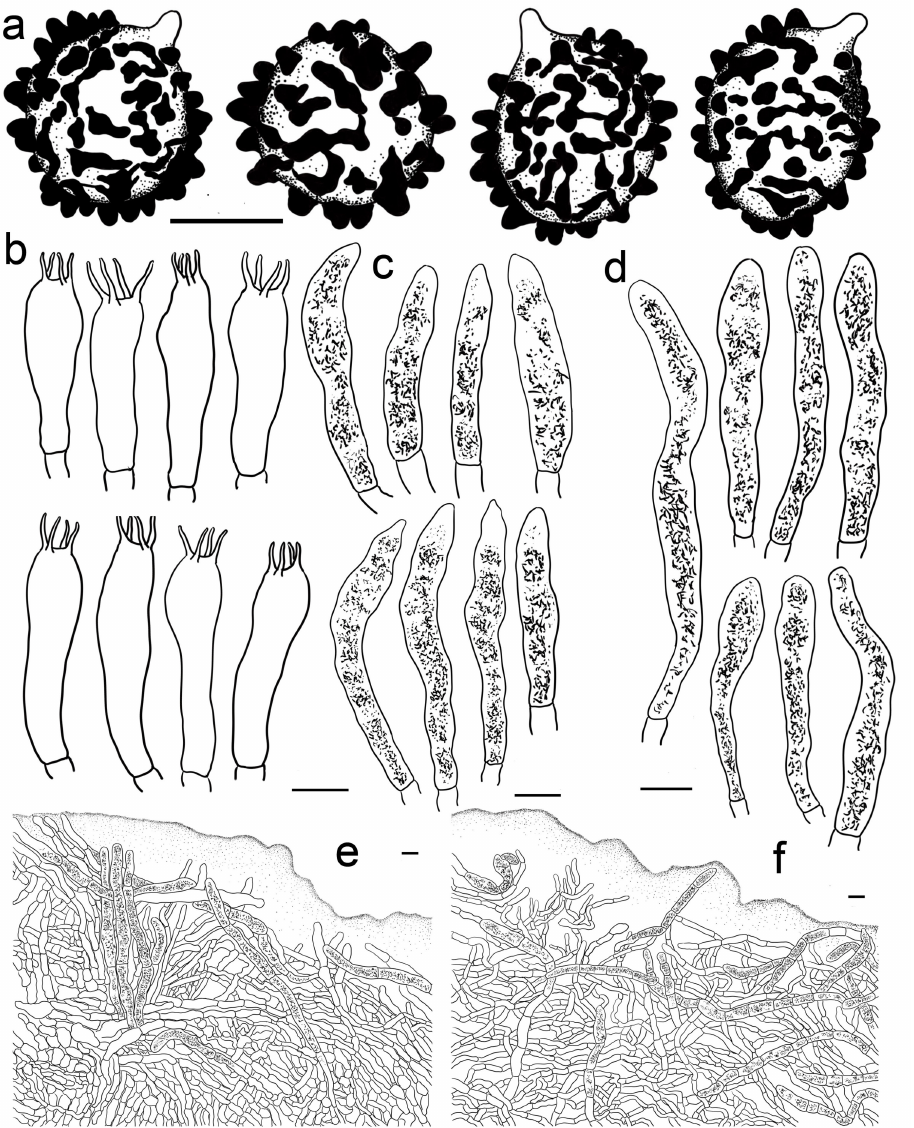
Figure 12. Russula roseola . (HMAS281958). ( a ) Basidiospores . ( b ) Basidia . ( c ) Cheilocystidia . ( d ) Pleurocystidia . ( e ) Suprapellis in pileus centre. ( f ) Suprapellis in pileus margin. Bars: ( a ) = 5 µ m, ( b – f ) = 10 µ m. Basidiospores (200/4/4) (5.8–) 6.2–9.3 (–9.8) × (4.6–) 5.0–8.1 (–7.8) µ m, Q = (1.06–) 1.09–1.38 (–1.35) (Q = 1.20 ± 0.08), 7.6 × 6.2 µ m on average, subglobose to broadly